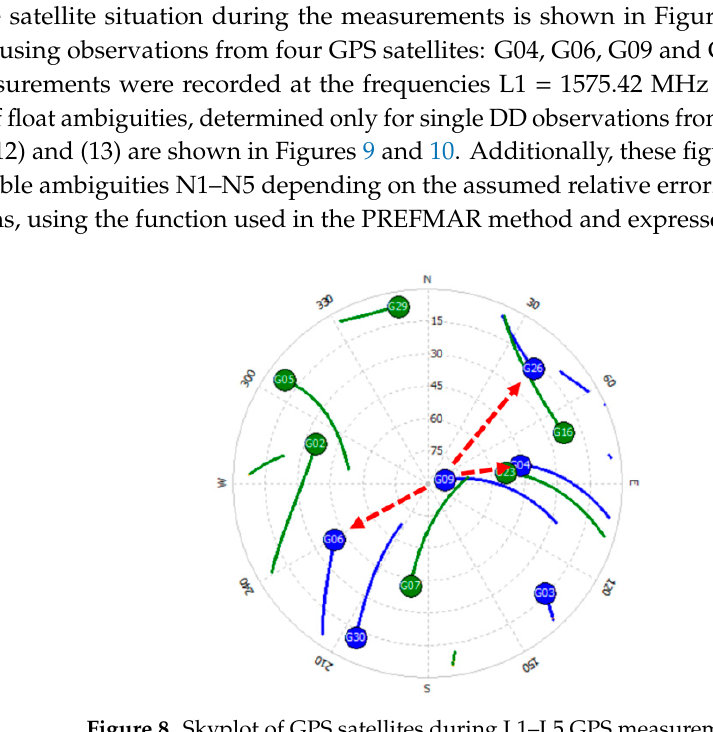
Figure 8. Skyplot of GPS satellites during L1–L5 GPS measurements.